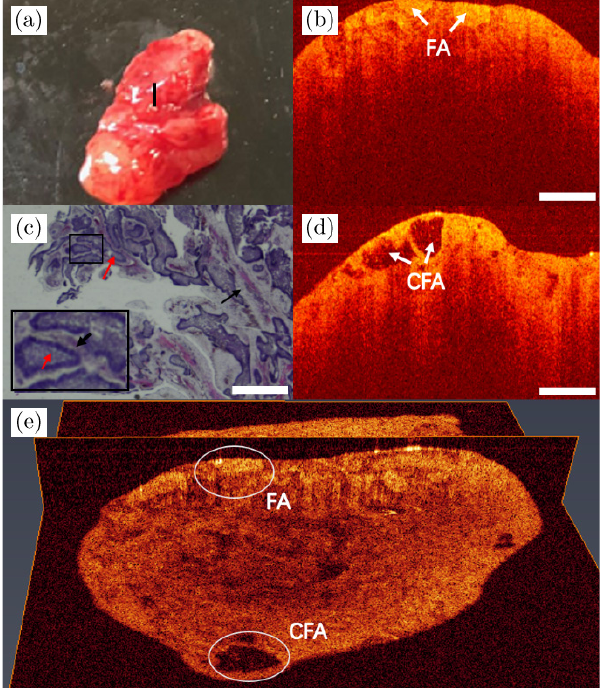
Fig. 7. Images of ameloblastoma. (a) Photo of the excised tissue specimen. (b) and (d) Two 2D OCT images from dif- ferent positions with follicular ameloblastoma. (c) Its histo- pathological image. (e) A 3D OCT image, the white ovals indicate the lesion areas. FA: follicular ameloblastoma and CFA: cystic structure of follicular ameloblastoma.